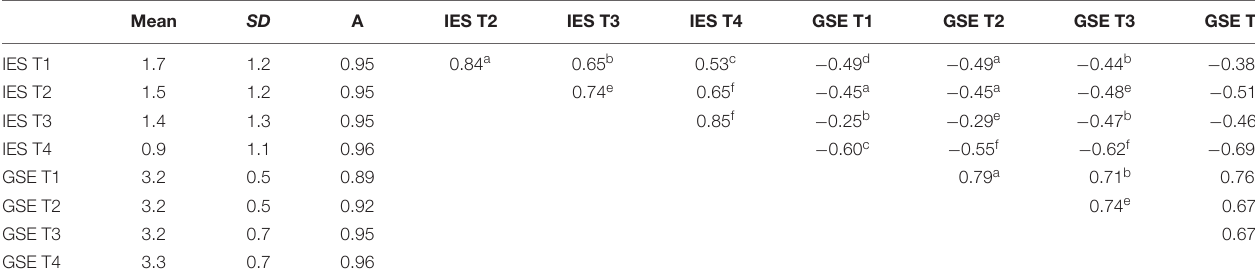
TABLE 2 | Descriptive statistics and correlation matrix between posttraumatic stress symptoms and general self-efficacy (GSE) over time. Mean SD A IES T2